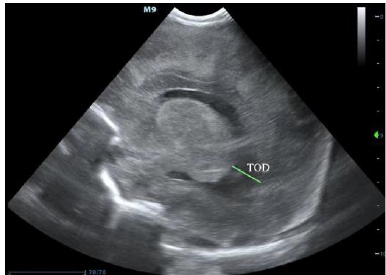
Figure 2. Illustration of TOD measurement (source: from a very premature infant with gestational age of 30 +3 weeks and diagnosed with IVH and PHVD in the department of neonatology, Guang- dong Women and Children Hospital. IVH: intraventricular hemorrhage, PHVD: posthemorrhagic ventricular dilatation, TOD: thalamo-occipital distance).